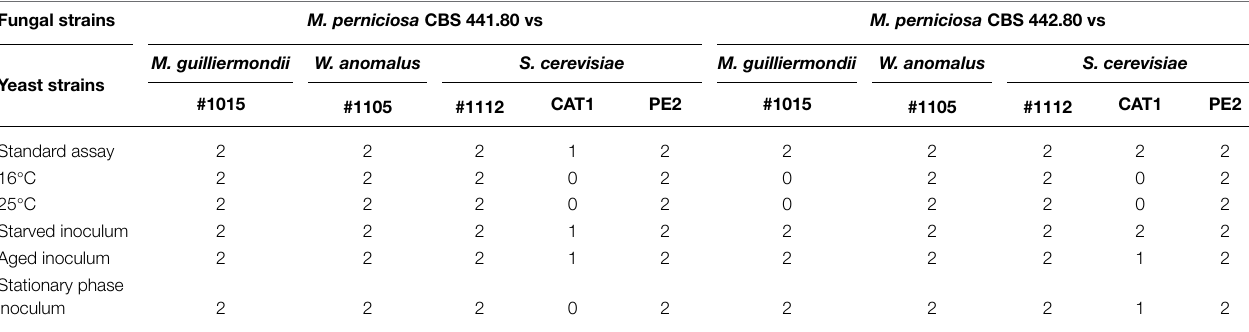
TABLE 4 | Antagonism assays using selected combinations of yeast and filamentous fungal strains, challenged with environmental stressors. Fungal